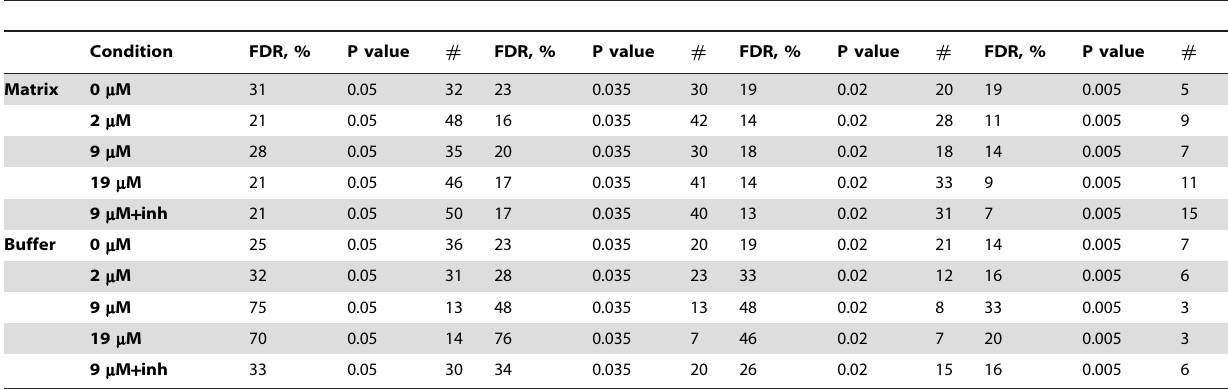
Table 2. Estimated false discovery rates (FDR), P value threshold (paired t-test), and corresponding number of metabolites ( # ) that changed over the 20-min incubation in each fraction (matrix,